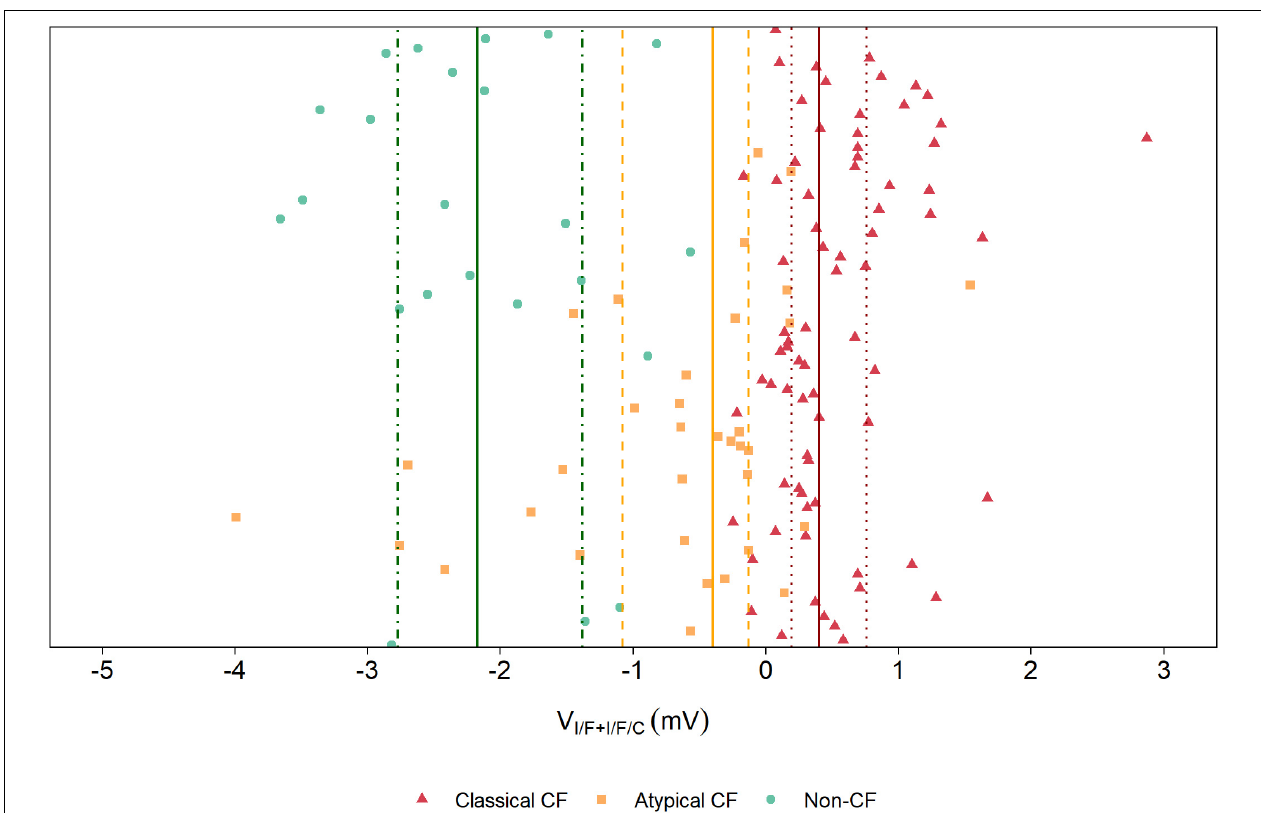
FIGURE 8 | Distribution of V I / F + I / F / C values in the studied cohort. A distribution showing the relative position of each individual in this study according to the new suggested parameter show that the median (line) of the V I / F + I / F / C for each diagnosis group and the 25%/75% percentile (dotted line) clearly distinct Non-CF (green), Atypical CF (yellow) and Classical CF (red), and could be used to indicate whether a certain individual is more likely to have Classical CF, Atypical CF or